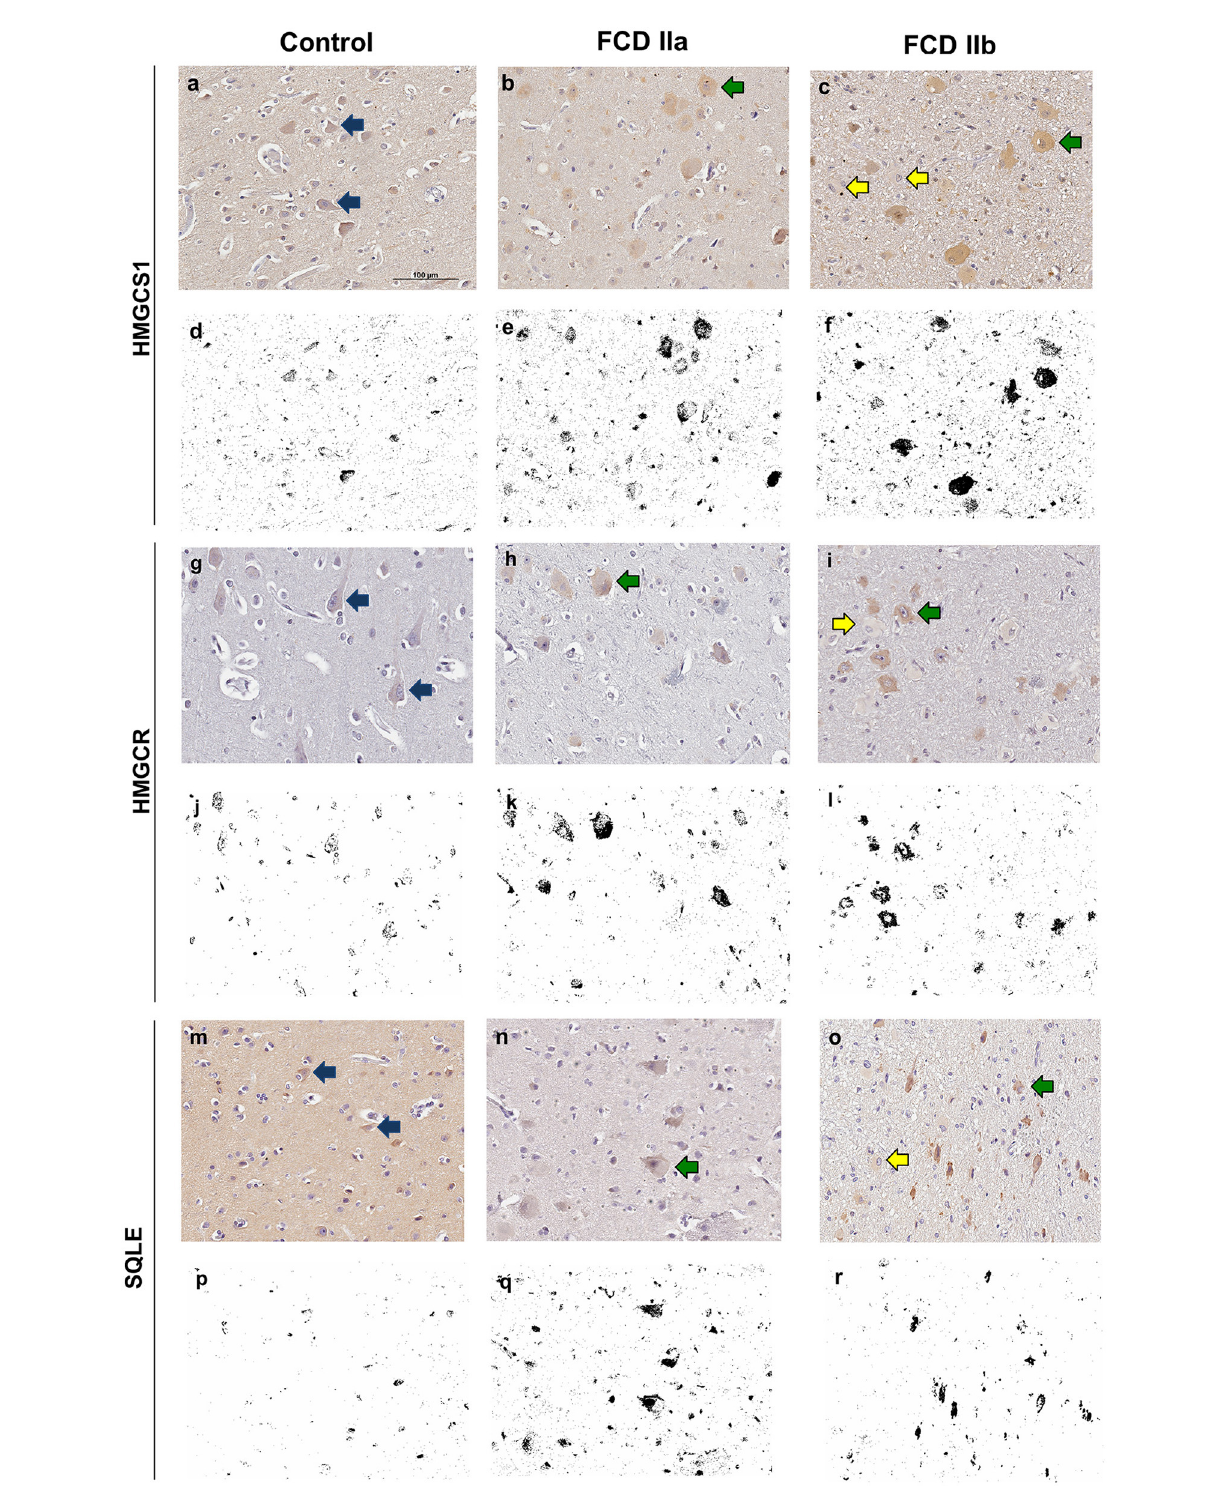
FIGURE6 Immunohistochemical reactions for 3-Hydroxy-3-Methylglutaryl-CoA Synthase 1 (HMGCS1), 3-Hydroxy-3-Methylglutaryl-CoA Reductase (HMGCR) and Squalene Epoxidase (SQLE) in the cortical layer of control (a, g, m) , focal cortical dysplasia (FCD) ILAE type IIa (FCD IIa) (b, h, n) and FCD ILAE type IIb (FCD IIb) (c, i, o) specimens. In FCD IIa and FCD IIb, a cytoplasmic staining was observed in dysmorphic neurons [green arrows in (b, c, h, i, n, o) ], in contrast with the negativity in balloon cells of FCD IIb lesions [yellow arrows in (c, i, o) ]. Normal neurons [blue arrows in (a, g, m) ] showed